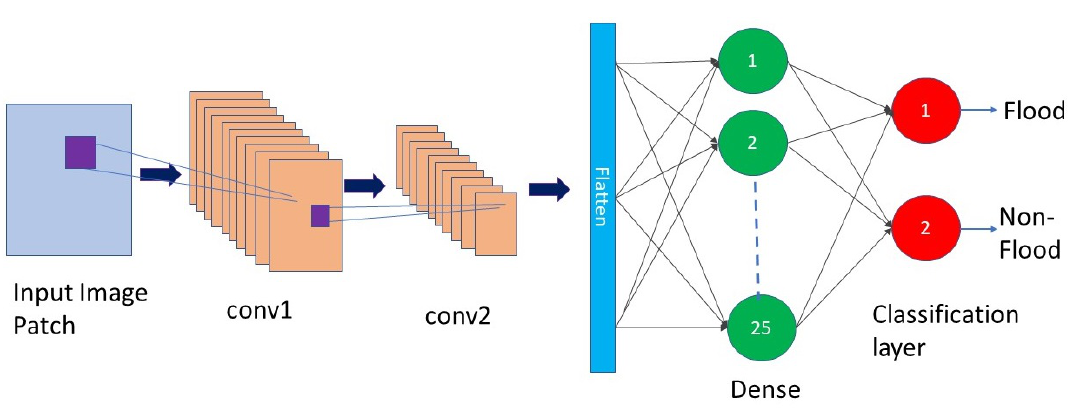
Figure 5. Deep Convolutional Neural Network